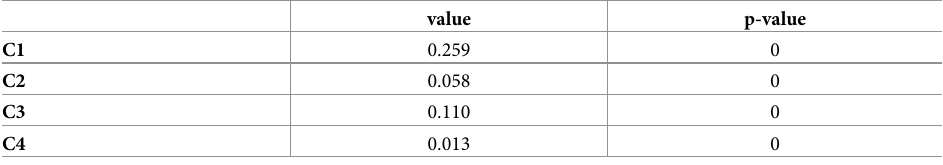
Distance-based measures of convergence and relative significance level as derived by the function convratsig in the R package